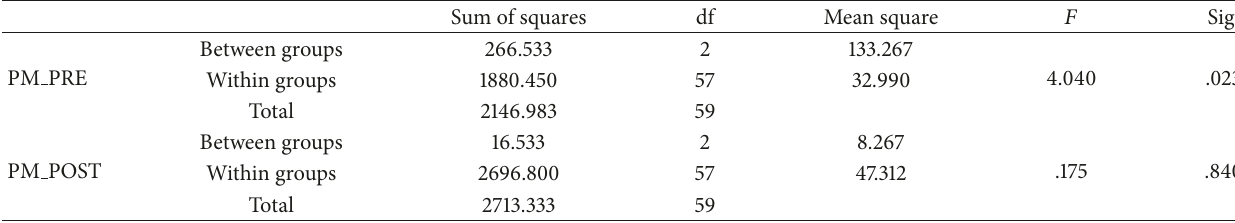
Table 7: Subgroup analysis for fortified milk group’s psychomotor scores.